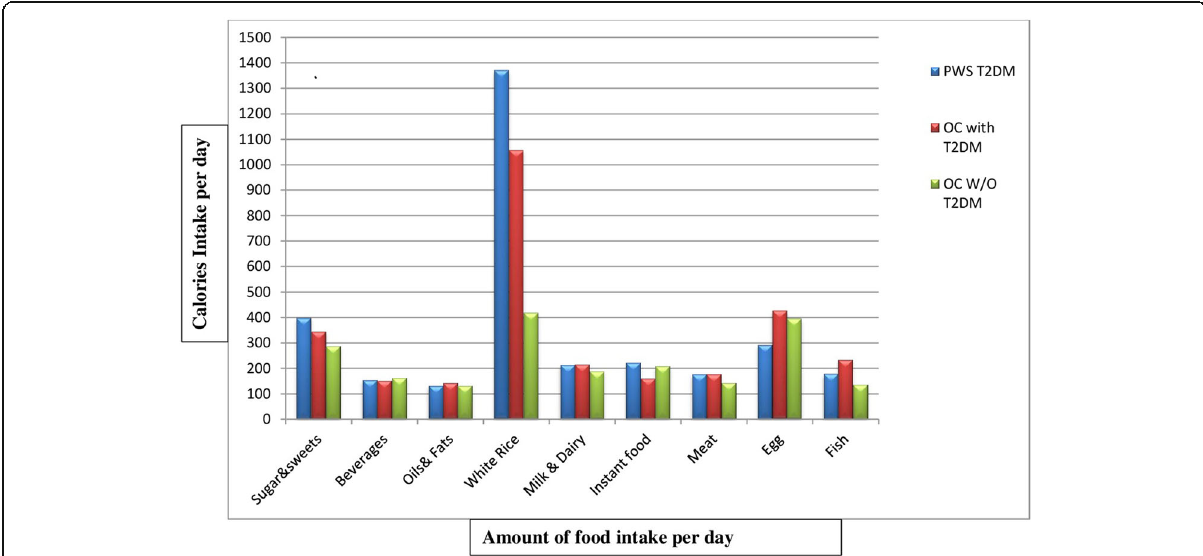
Fig. 1 Comparison of food and calorie intake per day for each food item in PWS and OC subject. The figure depicts the comparison of food and calorie intake per day for each food item in PWS, OC with T2DM, and OC without T2DM. The total intake of white rice, milk and dairy, instant food, and meat in PWS subjects was significantly higher when compared to that in OC subjects with T2DM and without T2DM ( p value 0.05). In contrast, the intake of sugar and sweets, beverage, oil and fat, egg, and fish in OC subjects both with T2DM and without T2DM was significantly higher than that in PWS subjects ( p value